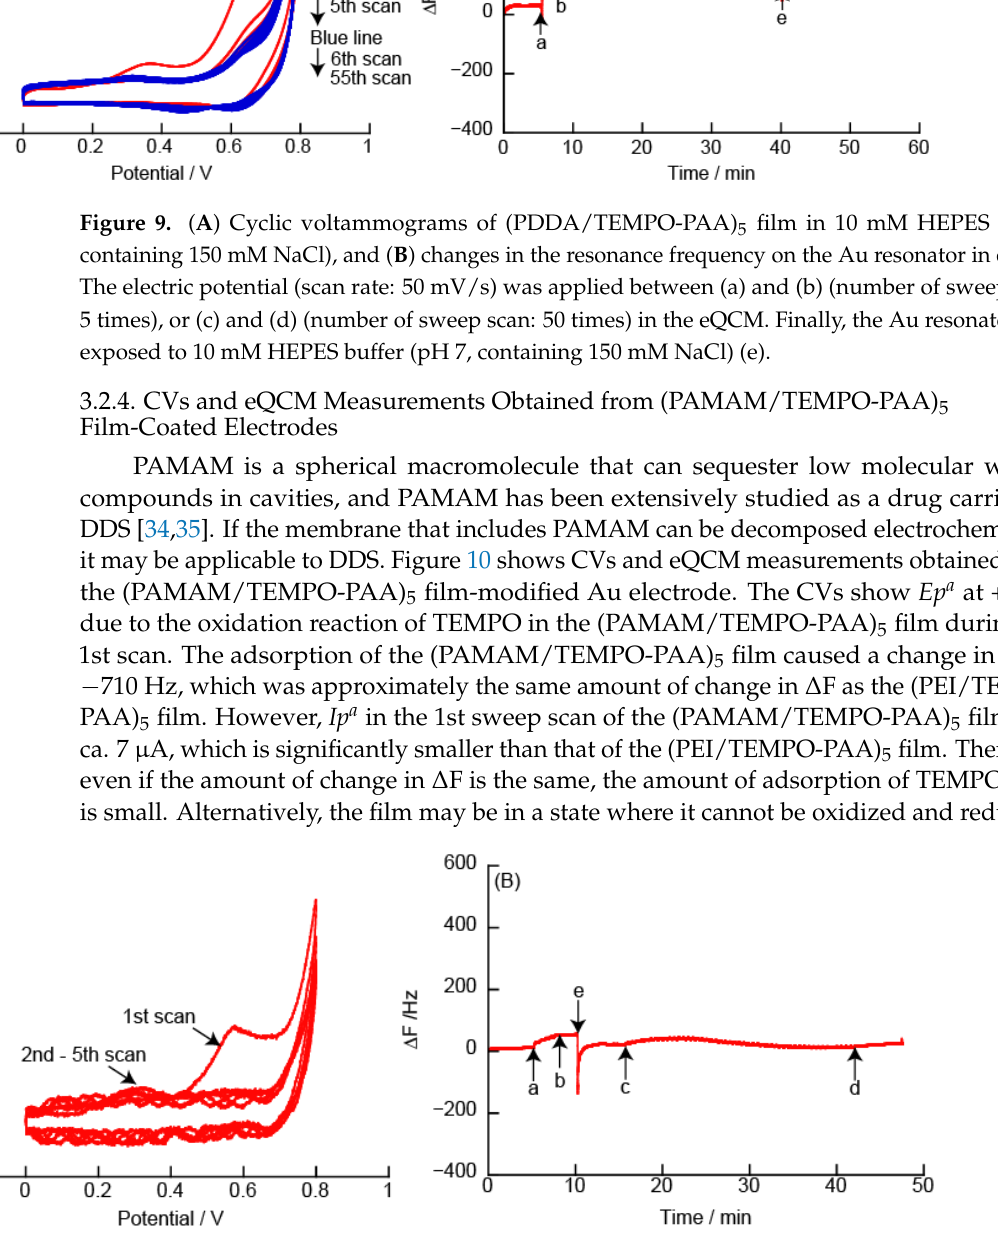
Figure 10. ( A ) Cyclic voltammograms of (PAMAM/TEMPO-PAA) 5 film in 10 mM HEPES (pH 7, containing 150 mM NaCl), and ( B ) changes in the resonance frequency on the Au resonator. The electric potential (scan rate: 50 mV/s) was applied between (a) and (b) (number of sweep scan: 5 times), or (c) and (d) (number of sweep scan: 50 times) in the eQCM. The Au resonator was exposed to 10 mM HEPES buffer (pH 7, containing 150 mM NaCl)